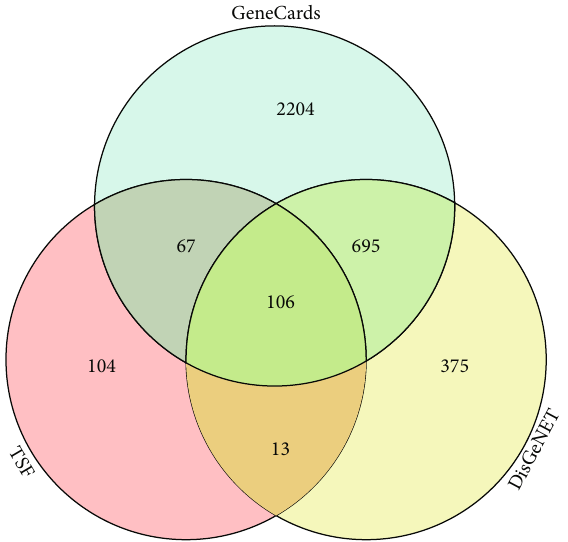
Figure 3: Intersection of target genes were mapped between diabetic nephropathy (DN) and Tangshen Formula